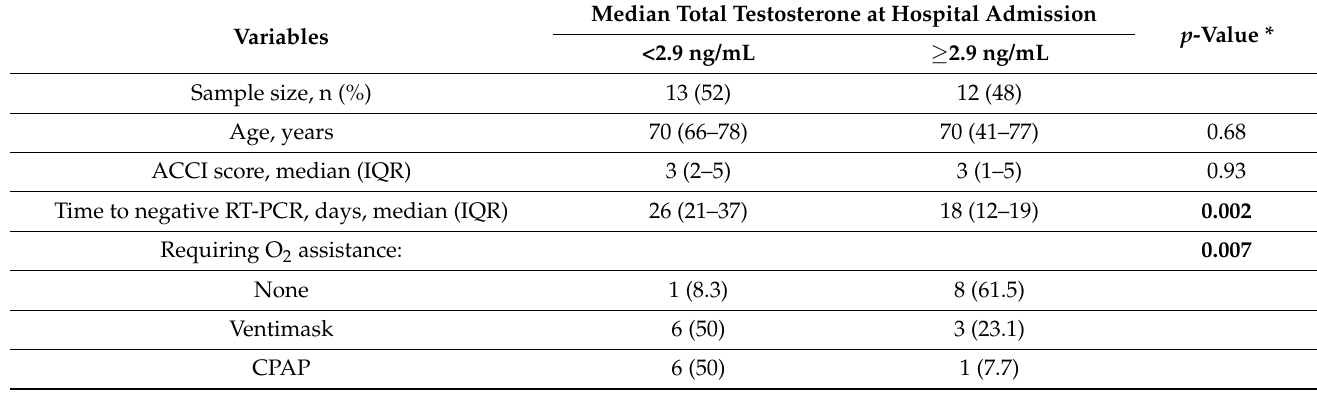
Table 1. Clinical and hemato-chemical characteristics of COVID-19 patients at hospital admission according to baseline total testosterone